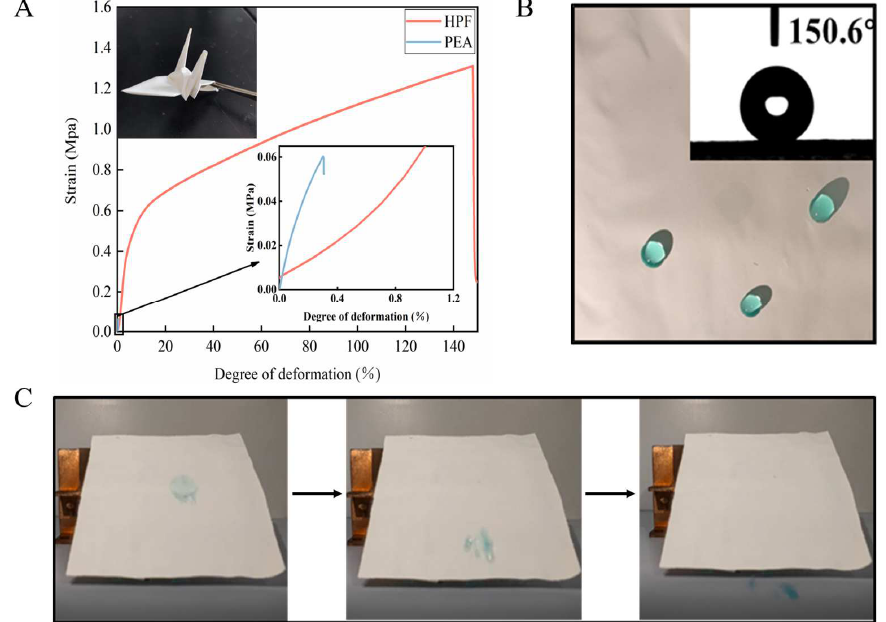
Figure 7. ( A ) Mechanical properties testing of PEA and HPF where the ZnO film used for the preparation of HPF can be folded into a cranes shape. ( B ) Water contact angle testing of HPF surfaces. ( C ) Demonstration of HPF’s self-cleaning